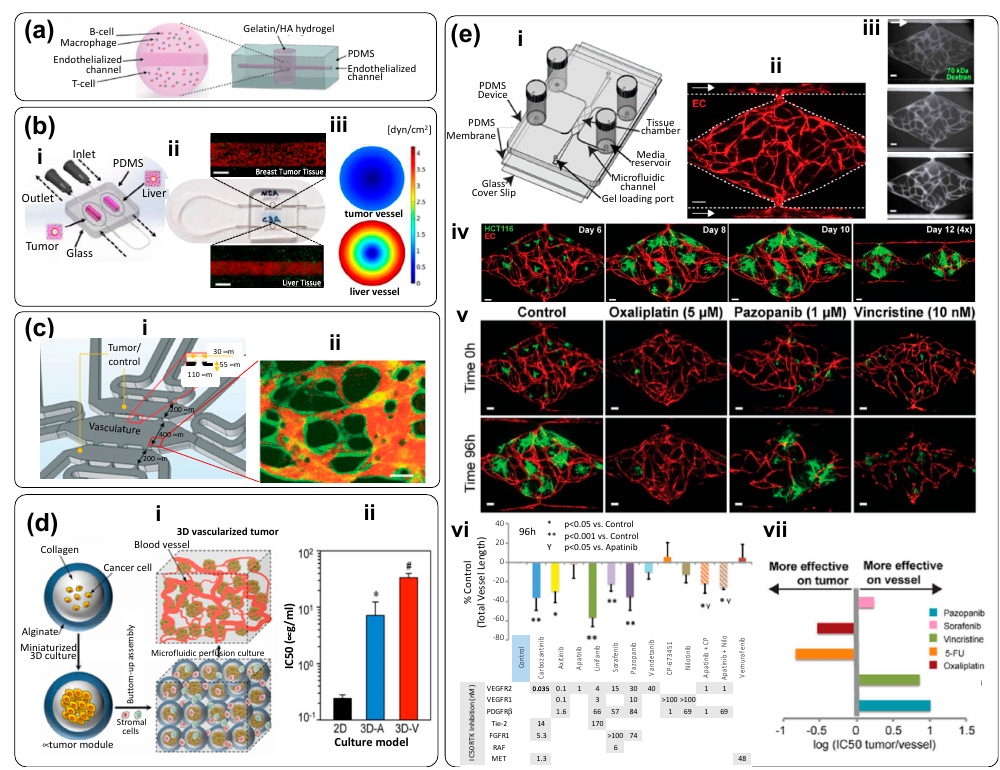
Figure 7. Vascularized tumor-on-chip (TOC) systems. ( a ) A gelatin and hyaluronic acid (HA) construct, built in a PDMS device, traversed by an endothelialized microchannel. Taken from reference [54]; ( b ) TOC devised by Ozkan et al. [55]. (i) Schematic representation of a breast tumor microenvironment connected to a healthy liver niche. (ii) Close-up view of the TOC system. Confocal images show GFP-breast cancer cells (green) and particles circulating inside the vascular channel (red) and FITC-anti-albumin immunostained healthy liver cells (green) and particles circulating inside the vascular channel (red). Scale bar: 500 μ m. (iii) CFD simulation showing the cross-sectional shear stress profiles in tumor and healthy vessels. Taken from reference [55]; ( c ) TOC by Shirure et al. [56]. (i) Schematic representation of the device, and (ii) confocal slice of the microvascular network (green) fabricated within the TOC central chamber and perfused with fluorescently labeled dextran (orange). Scale bar: 50 μ m. Taken from reference [56]; ( d ) Bottom-up engineering of vascularized tumor models proposed in Agarwal et al. [57]. (i) Schematic representation of the strategy. (ii) Comparison of the effect of docetaxel, expressed as IC50, for three different microtumor models: 2D (black), a-vascular 3D (blue) and vascularized 3D (red) models; (*) indicate statistically significant difference of p < 0.05 when 3D vascularized models are compared to 2D culture model, and (#) significant differences of p < 0.05 when 3D vascularized models are compared with 2D and 3D avascular culture models. Taken from reference [57]. ( e ) Vascularized tumor-on-chip developed by Sobrino et al. [58]. (i) Scheme of the microfluidic device: a PDMS microfluidic chip composed of an array of three tissue chambers, each connected to two straight channels mimicking an arteriole (line of higher pressure) and the venule (line of lower pressure). Channels were also connected to the medium inlets and outlets. A hydrostatic pressure differential of 10 mm H 2 O was established to enable flow across the microfluidic channel, while a pressure gradient of 5 mm H 2 O was set across the tissue chambers to favor transport across the hydrogel. (ii) A human-endothelial cell vasculature net was fabricated within diamond-shaped tissue chambers containing EC-like matrix. Remarkably, the development of vasculature in these tissue chambers occurred spontaneously by self-assembly of EC cells initially seeded within the channels and the tissue chamber at day zero. Endothelial cells were continuously transduced with mCherry for easy visualization of the network (iii) Experiments of continuous perfusion of Dextran X show that the vascular network is practically leak-free after several days. (iv) Growth of tumors, fabricated by a spheroid formation method assisted by thrombin, seeded within the vasculature network models after 6, 8, 10, and 12 days of culture at continuous perfusion. (v) Different drugs were tested in this tumor-on-chip system; (vi and vii) the model correctly discriminates between drugs that target the tumor-vasculature formation capabilities and those that target the tumor. Scale bars: 50 µ m. Taken from reference